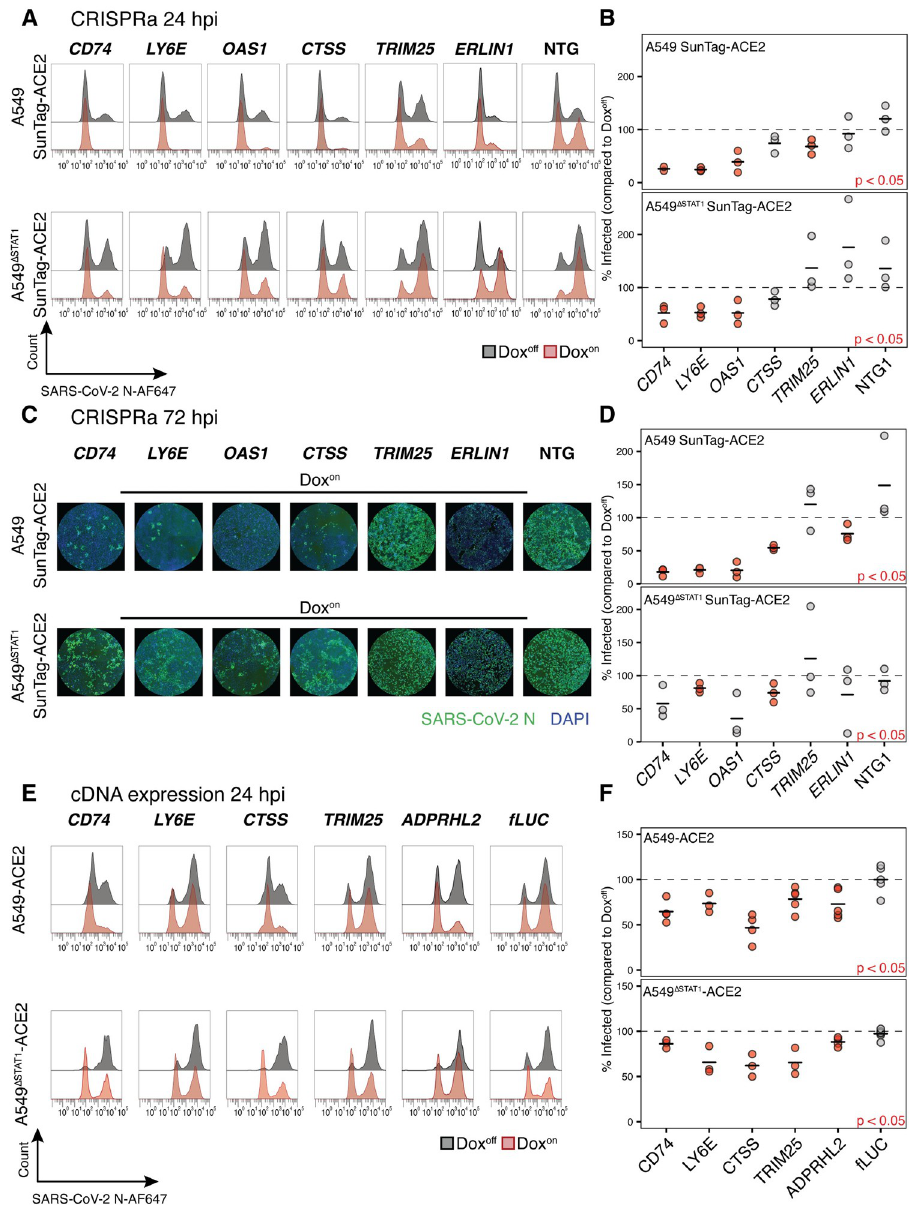
Fig 3. Validation of ISG screen hits in targeted CRISPRa and ectopic cDNA expression studies. (A) Representative flow cytometry histograms for SARS-CoV-2 N protein in A549-SunTag ACE2 and A549 Δ STAT1 -SunTag ACE2 transduced with indicated gRNAs, treated (red) or not treated (gray) with Dox, at 24 hours post-infection with SARS-CoV-2 (M.O.I. = 2). ( B) Percent of infected (SARS-CoV-2 N protein positive) cells quantified across biological replicates (n = 3, n = 2 for CD74 gRNA in A549-SunTag ACE2 cells) for experiments described in (A). Values denote percent of infected cells in Dox on cultures relative to paired Dox off cultures. Points represent individual biological replicates, black lines indicate mean values of biological replicates for each indicated ISG gRNA. Red points indicate statistical significance (p < 0.05) as determined by paired ratio Student’s t-test. (C) Representative immunofluorescence images for SARS-CoV-2 N protein and DAPI in A549-SunTag ACE2 and A549 Δ STAT1 -SunTag ACE2 transduced with indicated gRNAs and treated with Dox, at 72 hours post-infection with SARS-CoV-2 (M.O.I. = 2). (D) Percent of infected (SARS-CoV-2 N protein positive) cells quantified across biological replicates (n = 3, n = 2 for ADPRHL2 gRNA in A549-SunTag ACE cells) for experiments described in (C). Values denote percent of infected cells in Dox on cultures relative to paired Dox off cultures. Points represent individual biological replicates, black lines indicate mean values of biological replicates for each indicated ISG gRNA. Statistical significance as in (B). (E) Representative flow cytometry histograms for SARS-CoV-2 N protein in A549 ACE2 and A549 Δ STAT1 ACE2